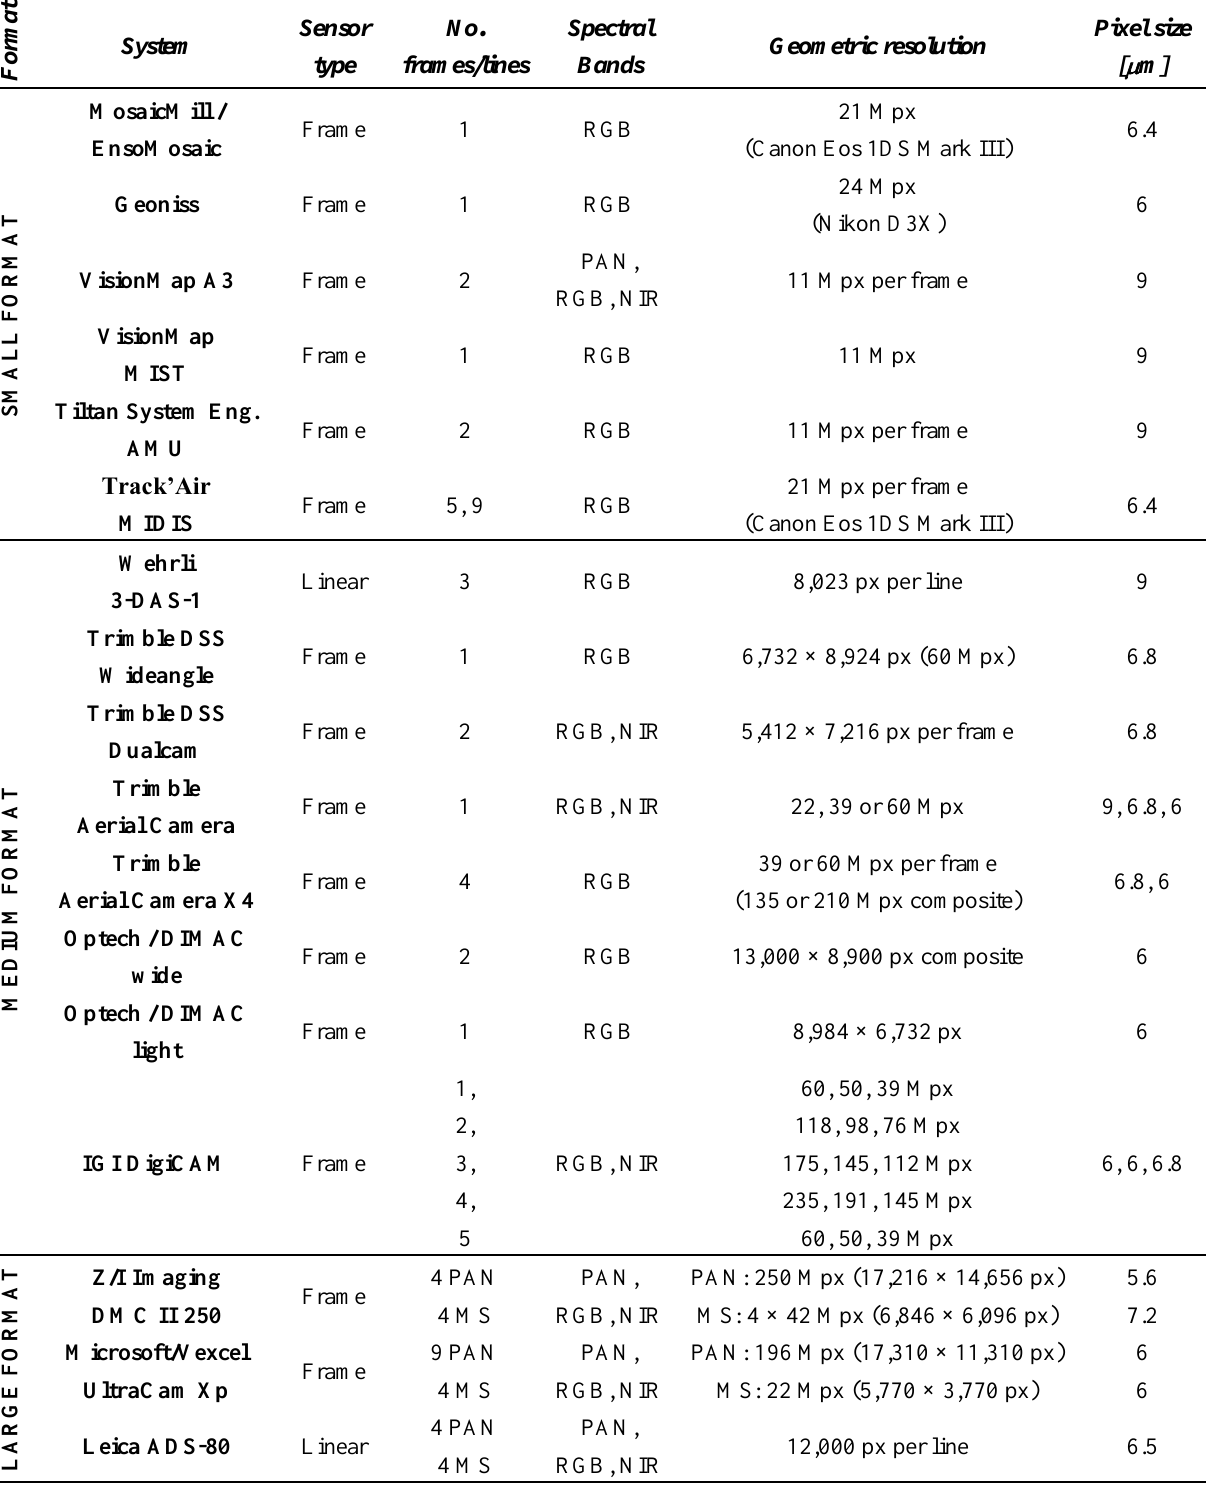
Table 6. Primary airborne digital cameras and